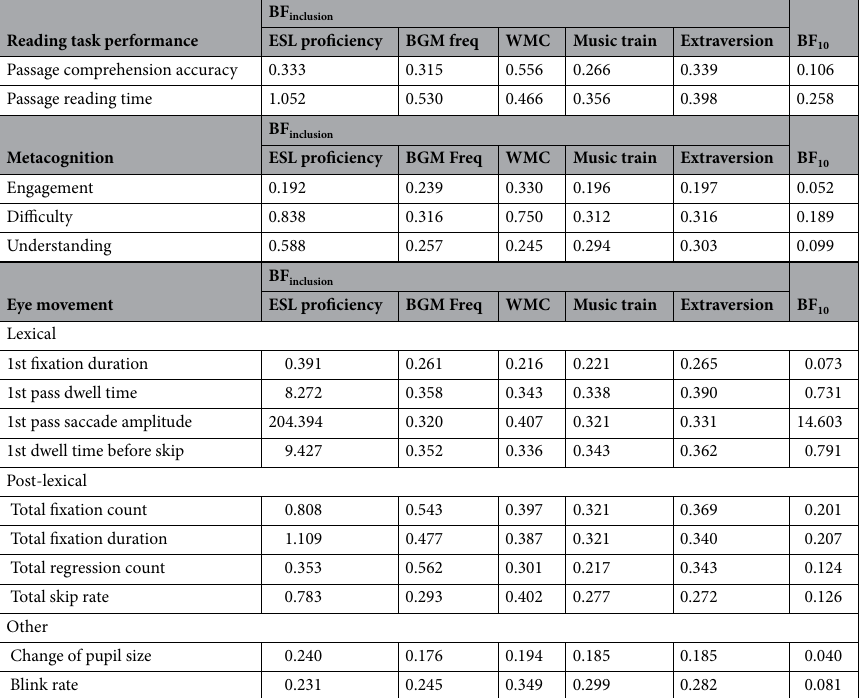
Table 9. Bayesian linear regression models of silence group (Control). Please refer to Note below Table 6 for abbreviation definition.